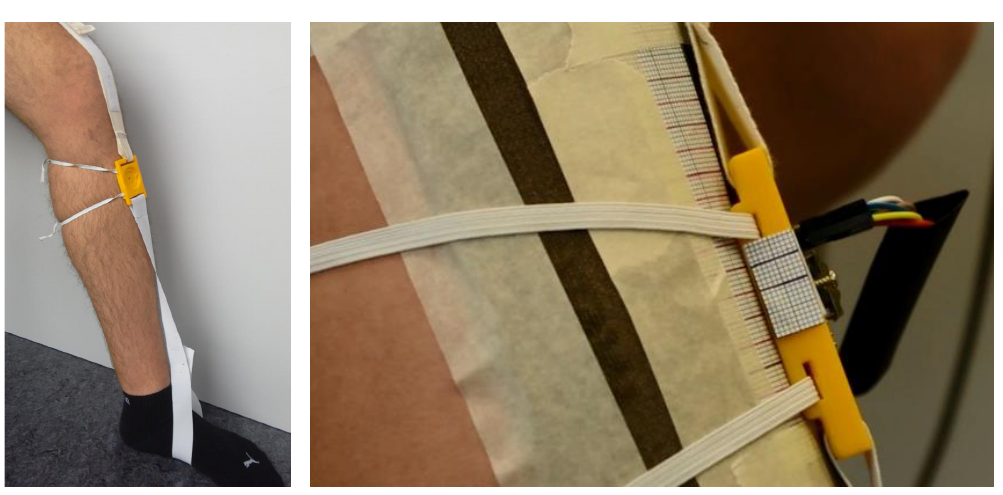
Figure 8. Measurement setup to assess sensor functionality during unloaded knee bends: sensor platform with elastic attachment ( left ) and integration of quantification method ( right